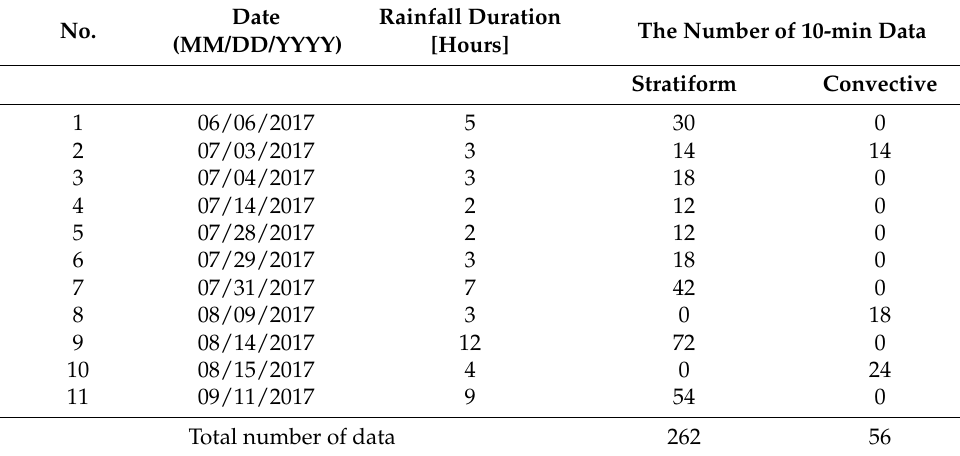
Table 3. Characteristics of the rainfall event used in